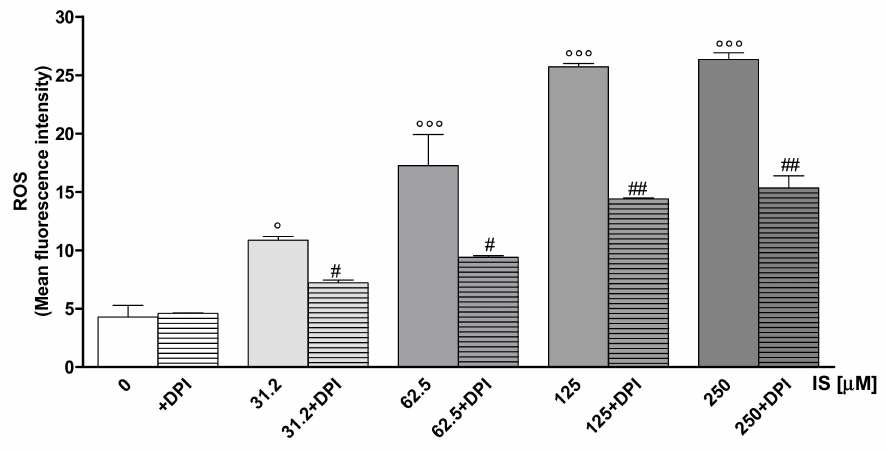
Figure 1. E ff ect of IS (31.2–250 µ M), alone or in the presence of DPI, on ROS formation, evaluated by means of the probe 2 (cid:48) ,7 (cid:48) dichlorofluorescein-diacetate (H 2 DCF-DA) in IEC-6 cells. Fluorescence-activated cell sorting analysis (FACSscan; Becton Dickinson) was used to measure cellular fluorescence ( n = 15). Data were elaborated with Cell Quest software. ◦◦◦ and ◦ denote p < 0.001 and p < 0.05 vs. control; ## and # denote p < 0.01 and p < 0.05 vs. IS